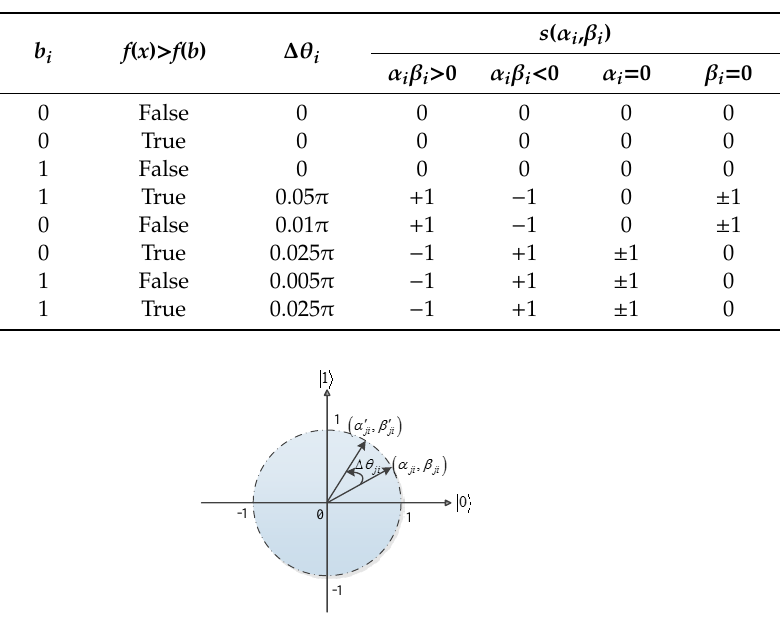
Figure 3. The polar plot of the rotation gate for a qubit individual.